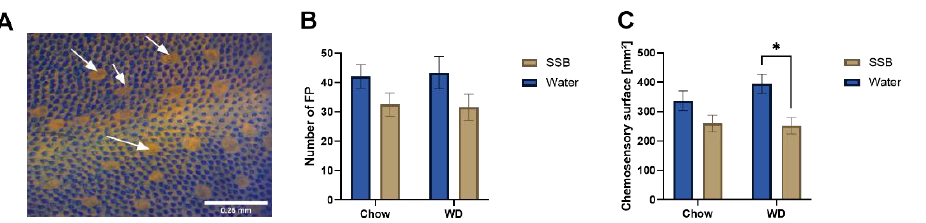
8 of 17 Figure 2. ( A ) Mean body weight ( n = 11 – 12 for chow group, n = 7 – 8 for WD group), ( B ) mean lean/fat mass ratio, ( n = 11 – 12 for chow group, n = 7 – 8 for WD group), ( C ) total mass of brown adipose tissue (BAT), ( n = 9 – 12 for chow group, n = 7 – 8 for WD group), ( D ) mean body temperature ( n = 11 – 12 for chow group, n = 5 – 8 for WD group), ( E ) mean fasting glucose level, ( n = 11 – 12 for chow group, n = 7 – 8 for WD group), ( F ) mean fasting plasma insulin concentrations ( n = 11 – 12 for chow group, n = 7 – 8 for WD group), ( G ) mean values for quantitative insulin sensitivity check index (QUICKI) ( n = 9 – 11 for chow group, n = 7 – 8 for WD group), and ( H ) mean area under the curve (AUC) obtained from glucose concentrations during an oral glucose tolerance test ( n = 11 – 12 for chow group, n = 7 – 8 for WD group ) . Data is shown as mean ± SEM, from mice receiving either a standard diet (chow) or Western-type diet (WD) with water (Water, blue bars) or a sugar-sweetened beverage (SSB, brown bars) as a drink for 24 weeks. Statistical significance was tested using two-way ANOVA with the Holm – Sidak post hoc test, except for quantitative insulin sensitivity check index (QUICKI), which was analyzed using the Mann – Whitney U test due to a lack of equal variances. Significance was assumed at p < 0.05. * p < 0.05, ** p < 0.01. In addition, two-way ANOVA analysis revealed an impact of the consumed bever- age on fasting glucose concentrations ( p < 0.01, Figure 2E). Multiple comparison showed an increased fasting glucose concentration in mice that received SSB (6.6 ± 0.6 mmol/L) in comparison to water (4.4 ± 0.4 mmol/L) in the chow group ( p < 0.01), but not in the WD group. Both groups of mice receiving the WD had mean blood glucose concentrations of 6.5 ± 0.4 mmol/L in the SSB and 5.6 ± 0.6 mmol/L in the water group, which is higher than the chow/water group (Figure 2E). In addition, there was a direct relationship between fasting glucose concentrations and the waist circumference (r = 0.374, p < 0.05, Pearson’s correlation). The fasting plasma insulin concentrations were significantly higher in the WD/water group compared to the WD/SSB group ( p < 0.05, Figure 2F). Moreover, QUICKI, as a marker for insulin sensitivity, was lower in mice fed with the WD compared to the chow ( p < 0.05, Figure 2G). Still, there was no difference in the glucose area under the curve during the oral glucose tolerance test (oGTT) (Figure 2H). Plasma concentrations of TAG, total cholesterol, HDL-C, and LDL-C did not differ between the mice receiving either chow or WD with SSB or water as a drink (Supplemen- tary Material Figure S1). However, as expected, the body fat mass correlated with LDL-C (r = 0.41, p < 0.05). In addition, there was neither a difference in the systolic and diastolic blood pressure, nor in the heart rate between the different feeding groups at the end of the experiment (Supplementary Material Figure S2). The mean continuous metabolic syn- drome score showed no differences between the groups (Supplementary Material Figure S3). 3.3. Chemosensory Surface The total number of fungiform papillae at the anterior part in front of the intermolar eminence was determined and the results of the morphological surface analysis are shown 9 of 17 Figure 3. ( A ) Representative image for the analysis of the fungiform papillae after staining with